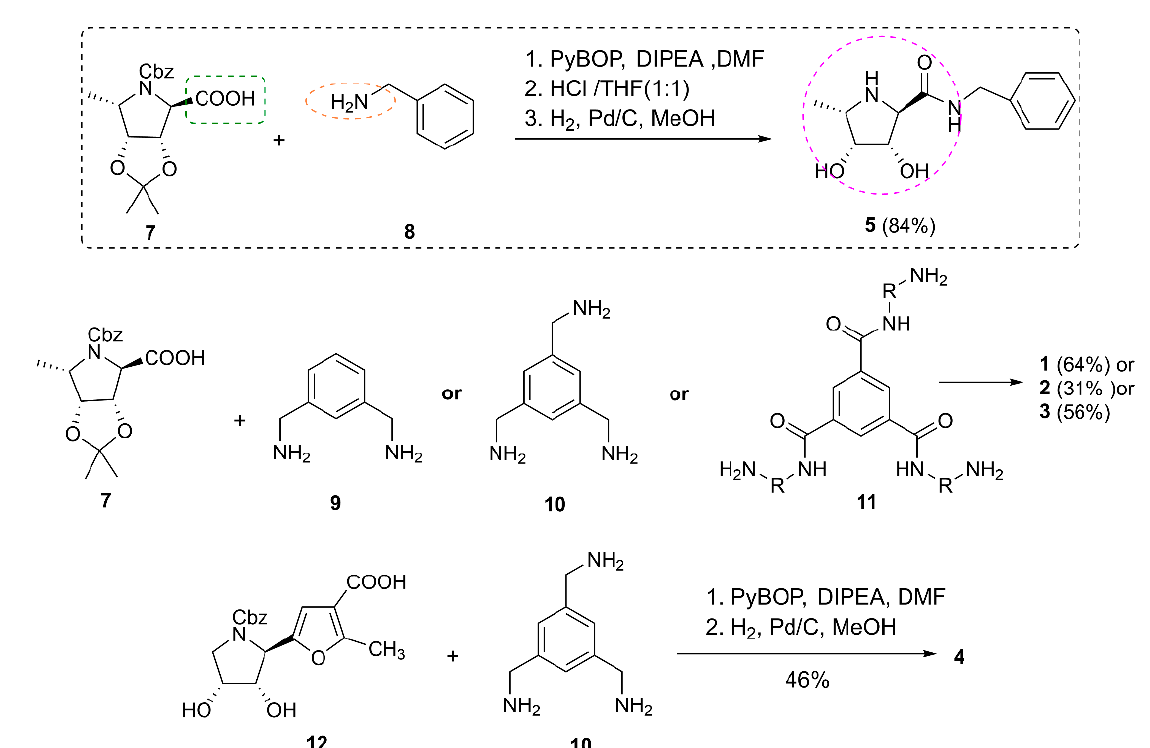
Scheme 1. Synthesis of di- and trivalent pyrrolidine iminosugars 1 – 4 .